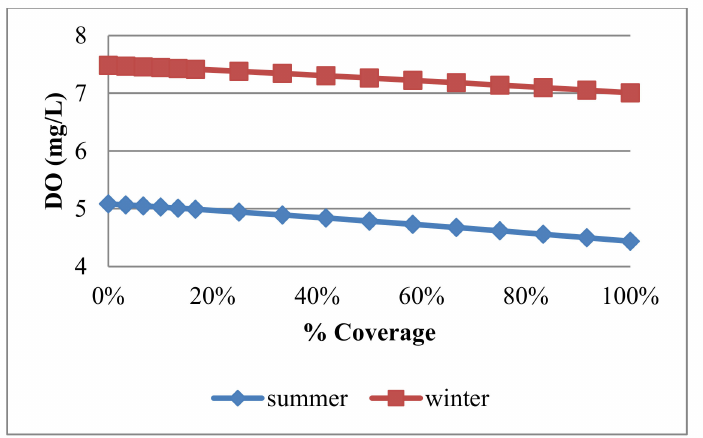
Figure 8. The DO concentration at the Canal end in the winter and summer versus percentage coverage for the 50-km length of the